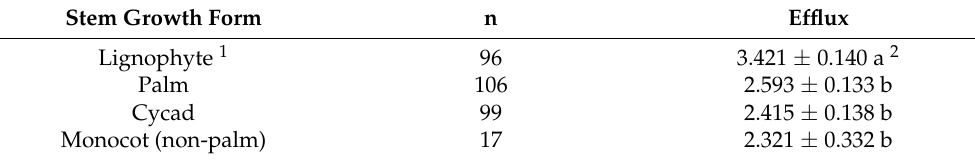
Table 1. Stem carbon dioxide efflux ( µ mol · m − 2 · s − 1 ) of arborescent species as influenced by the stem growth